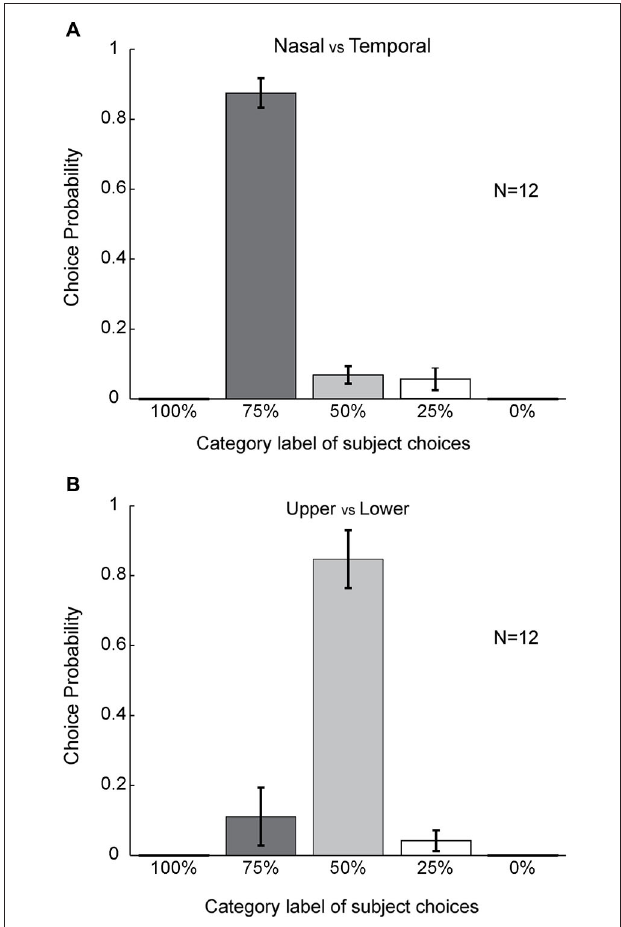
FIGURE 5 | Statistical analyses. (A) Population level choice probability for the different choice categories. Choice probability here is defined as the percentage of choices for each category label ( Figure 1 ) averaged across subjects (see Section Materials and Methods) ( n = 12). Error bars refer to SEM values. Columns were compared using the paired t -test. (B) Population level of choice probability for upper versus lower cases. Statistics were performed using the same method as in (A)